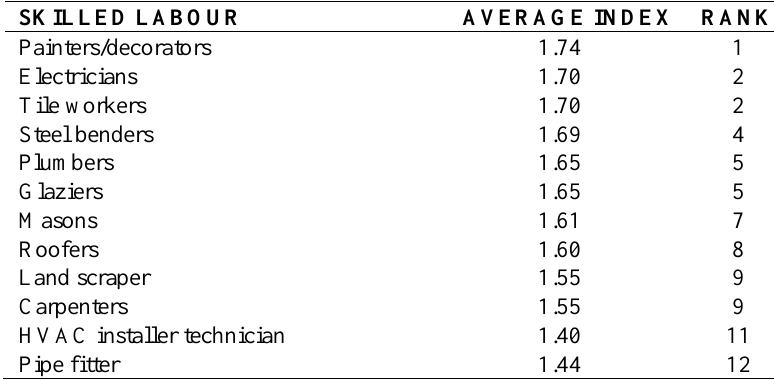
Table 1. Skilled Labour